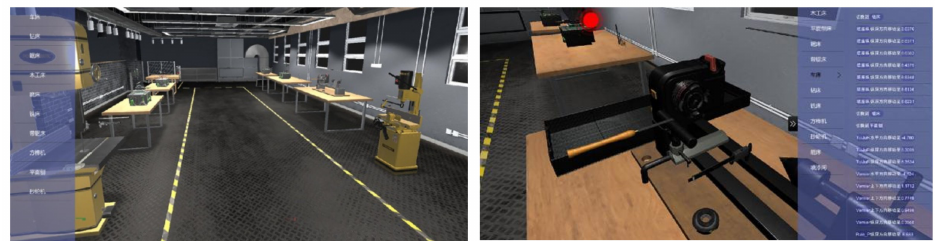
Figure 15. Operating system of the virtual woodworking